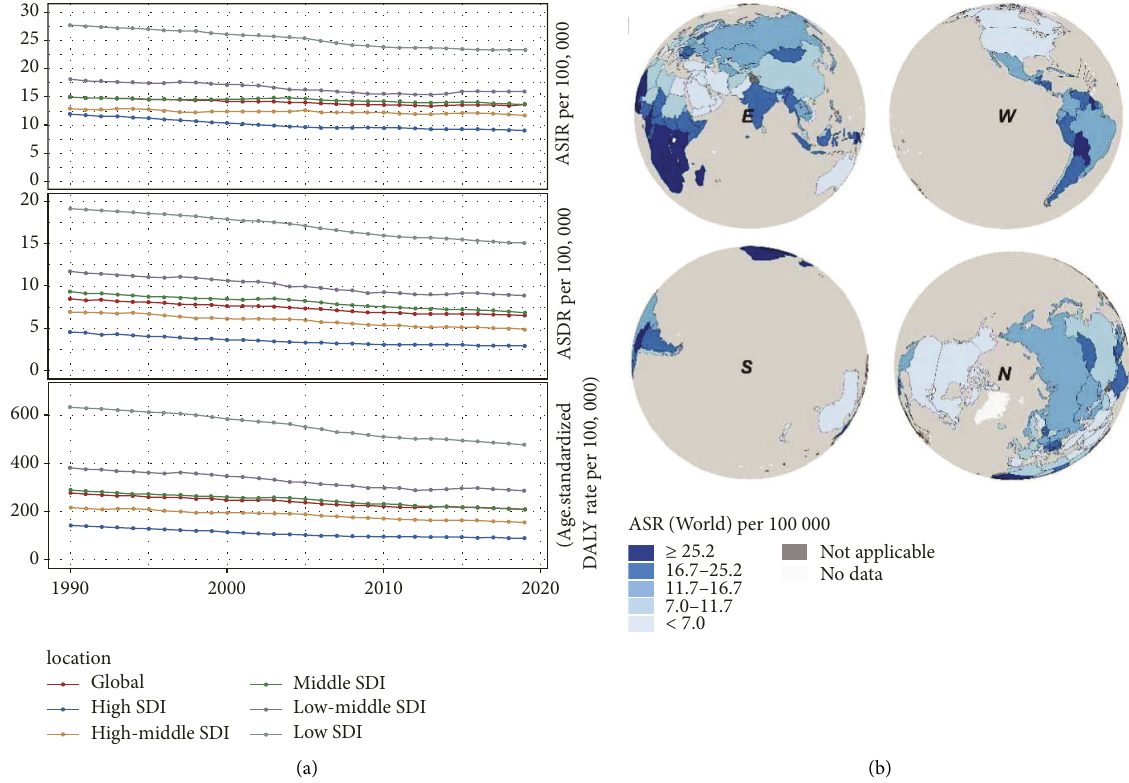
Figure 1: Trends in age-standardized incidence rate, mortality rate, and DALY rate among different SDI quantiles (a) and estimated age- standardized incidence rates on a global scale downward trend (Additional file1: Table S3 ). The top three countries in ASIR were Solomon Islands, Guinea, and Lesotho, respectively. The bottom three countries were Egypt, the Syrian Arab Republic, and Kuwait, respectively.